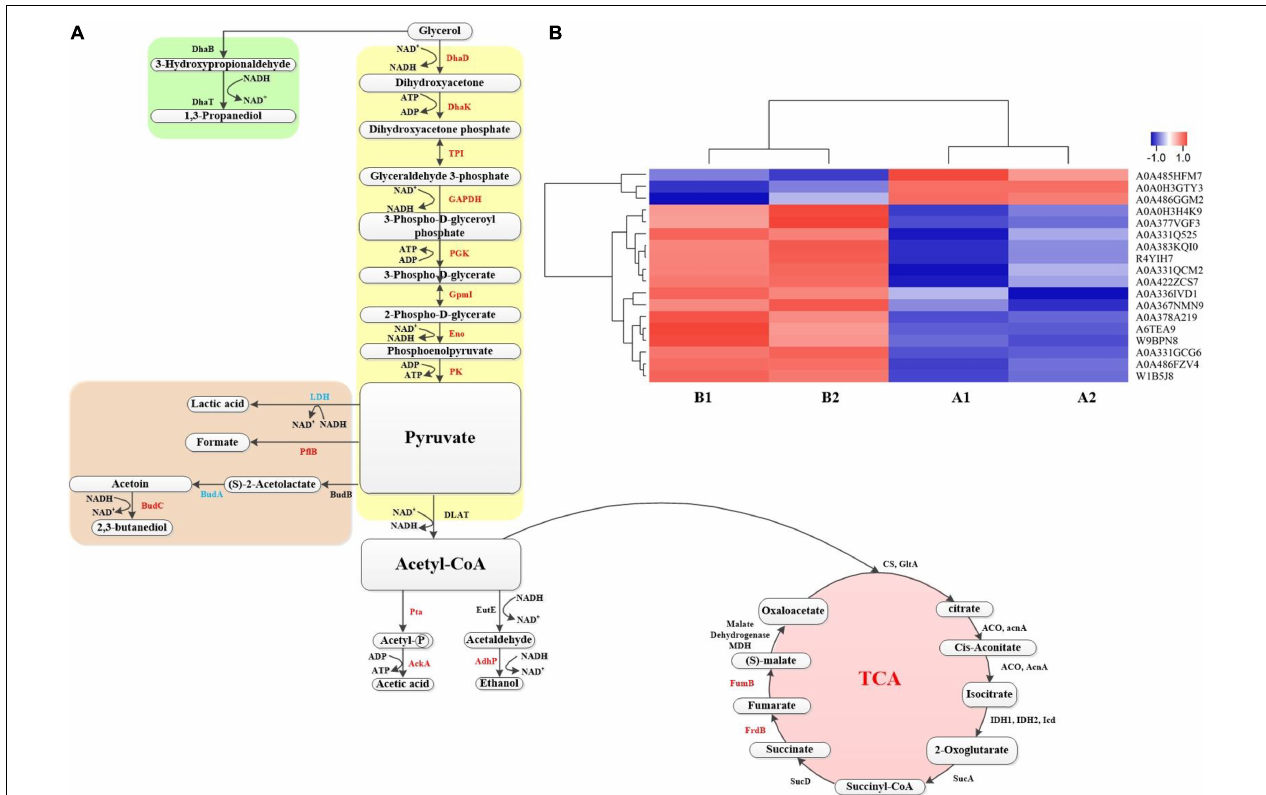
FIGURE 7 | (A) The metabolic pathway for production of 1,3-propanediol by K. pneumoniae . The red represents the up-proteins, and the blue represents the down proteins, whereas the black represents the no change. (B) Heat map of proteins on the metabolic pathway. Each column in the figure represents a sample, and each row represents a protein. The color in the figure represents the relative expression amount of the protein in the group of samples; red represents the high expression amount of the protein in the sample, and blue represents the low expression amount. For the specific change trend of the expression amount, see the number label under the color bar at the top